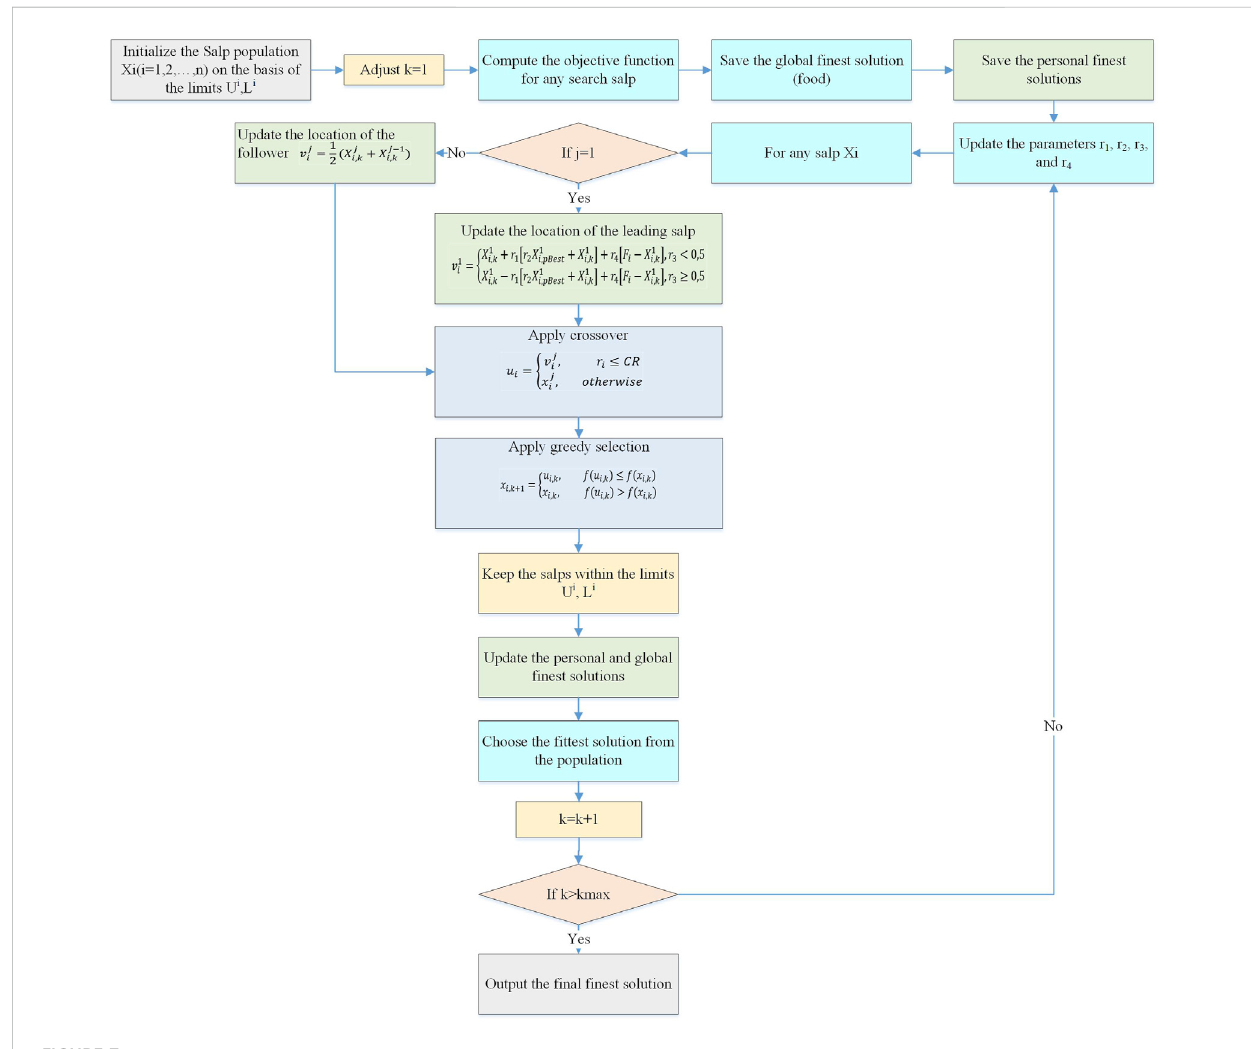
FIGURE 7 Flowchart of the ISS